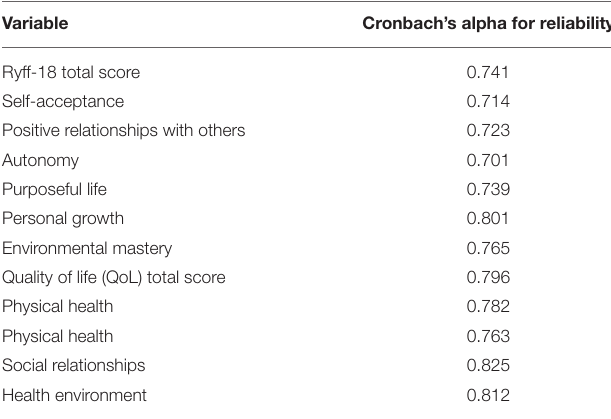
TABLE 4 | Reliability of the